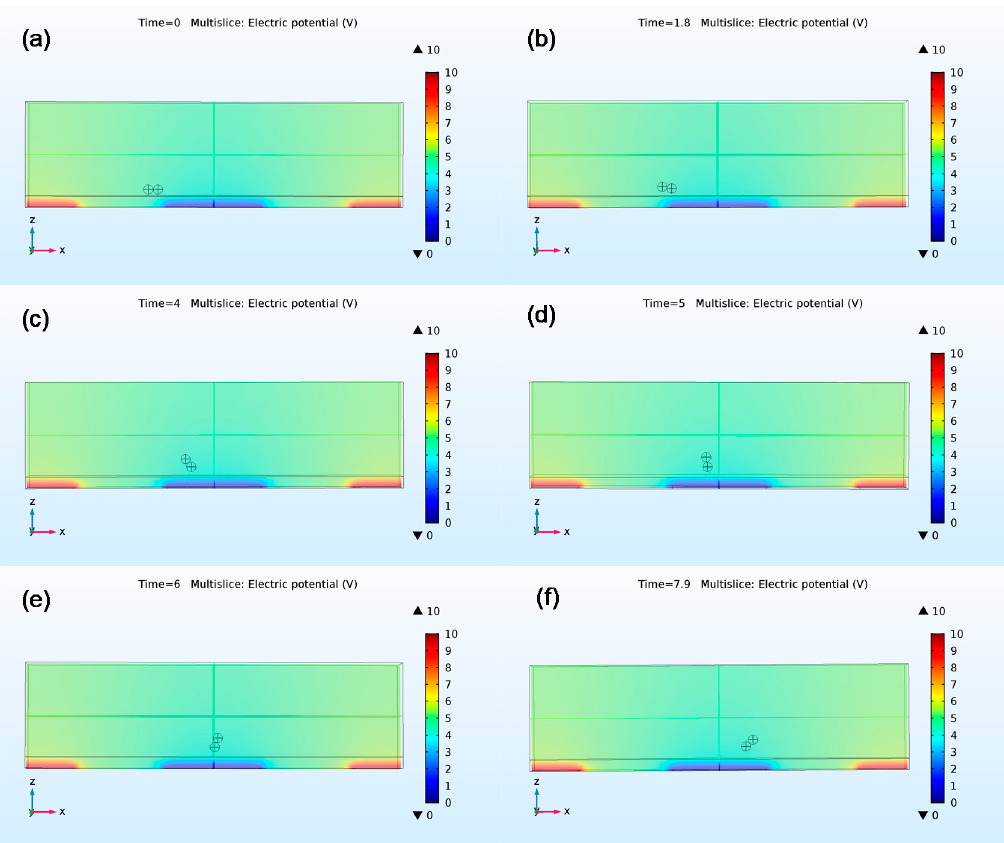
Figure 4. The orientation and position of chains formed by two particles simulated by coupled ALE- VPI method at different time points. ( a ) 0 s, ( b ) 1.8 s, ( c ) 4 s, ( d ) 5 s, ( e ) 6 s, ( f ) 7.9 s. The scale bar represents the potential distribution.